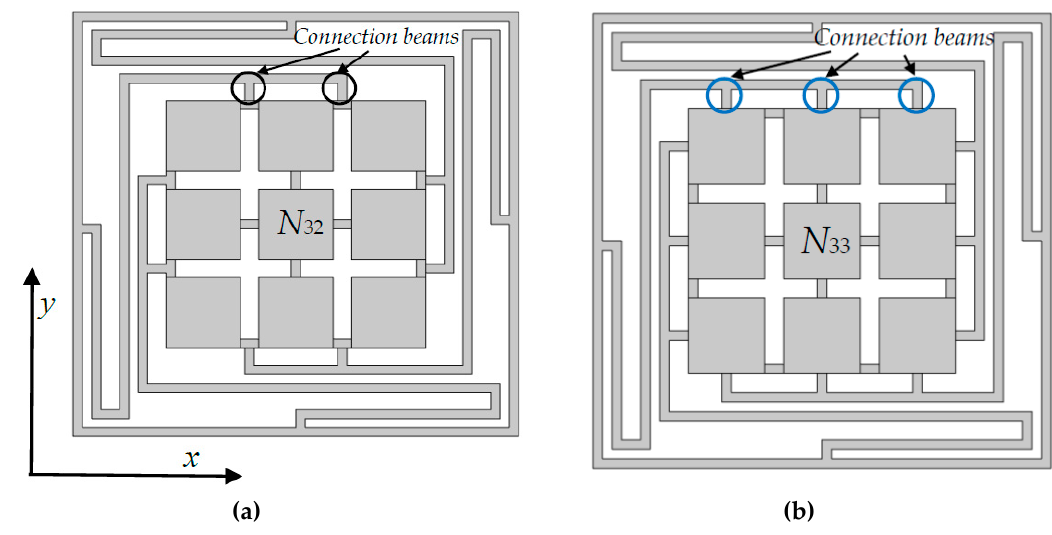
Figure 10. The diagrams of the connection beams on 3×3 model. ( a ) O c = 2; ( b ) O c = 3.